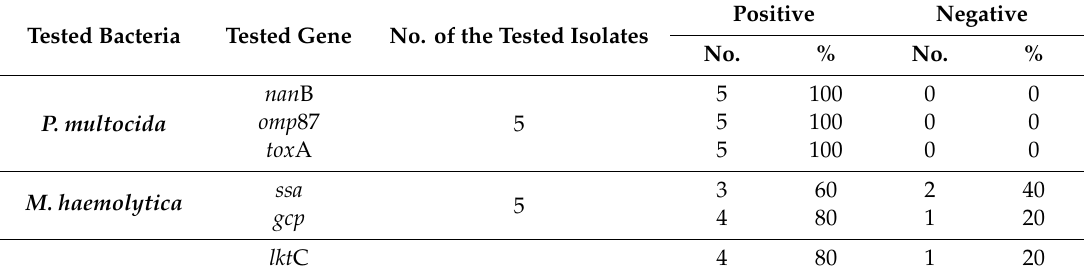
Table 5. Prevalenceofvirulence-associatedgenesamongtheexamined P.multocidaandM.haemolytica isolates. Tested Bacteria Tested